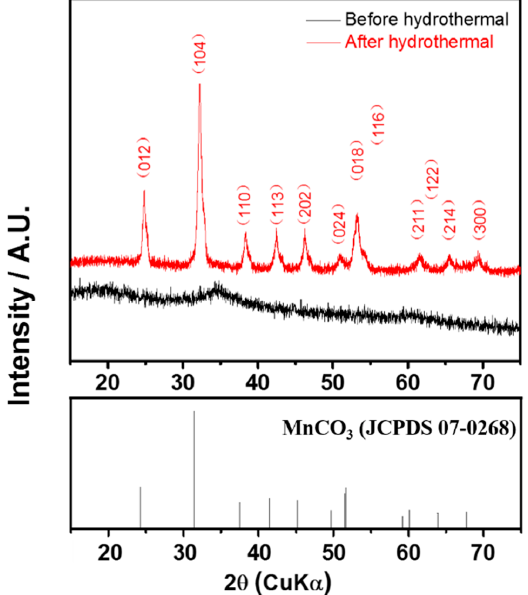
Figure 2. X-ray diffraction patterns for the precipitates before and after hydrothermal treatment. R M = 1:1:1 ( Ni:Co:Mn ) ; C M = 0.15 mol·L − 1 ; C (NH4 ) 2CO3 = 0.15 M; T h = 180 °C; t h = 24 h.